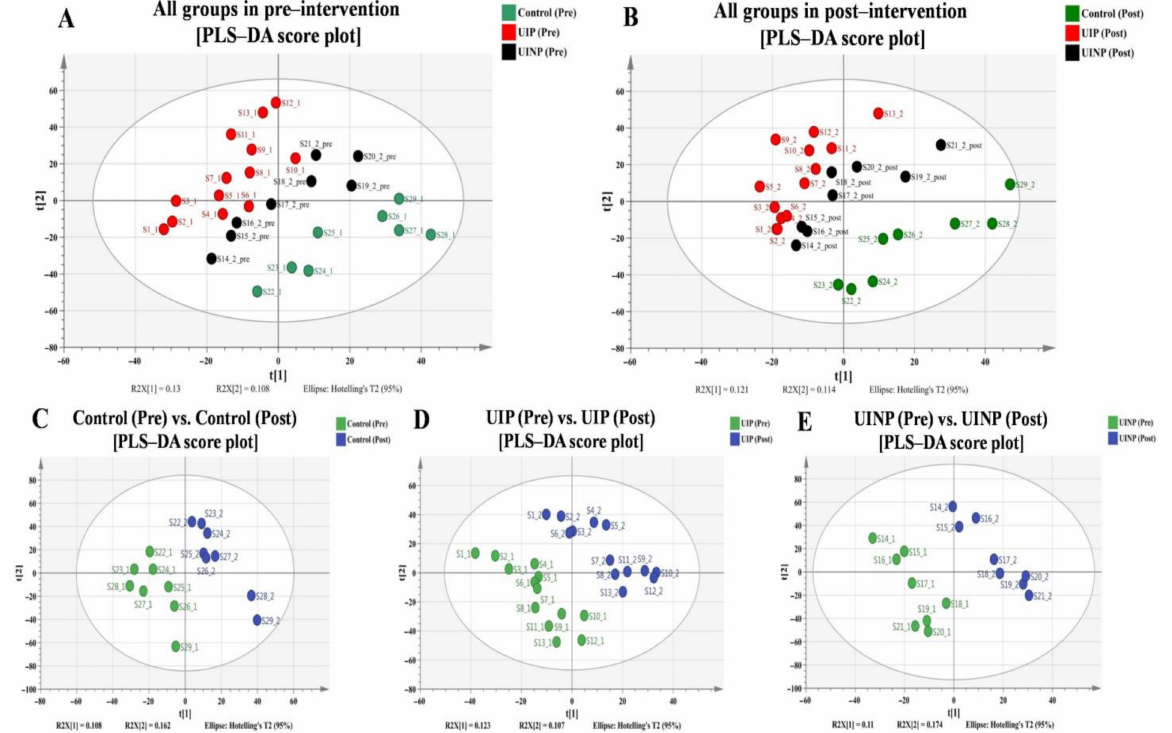
Figure 1. Multivariate statistical analysis using PLS-DA among all groups in pre-intervention, all groups in post-intervention, and between pre- and post-intervention in each group. PLS-DA: partial least squares discriminant analysis; Control: control group; UIP: urinary incontinence group with Pilates; UINP: urinary incontinence group with no Pilates; t [1]: first principal component score; t [2]: second principal component score; R2X: cumulative variance contribution rate; Hotelling’s T2: indication that all samples are located within 95% confidence